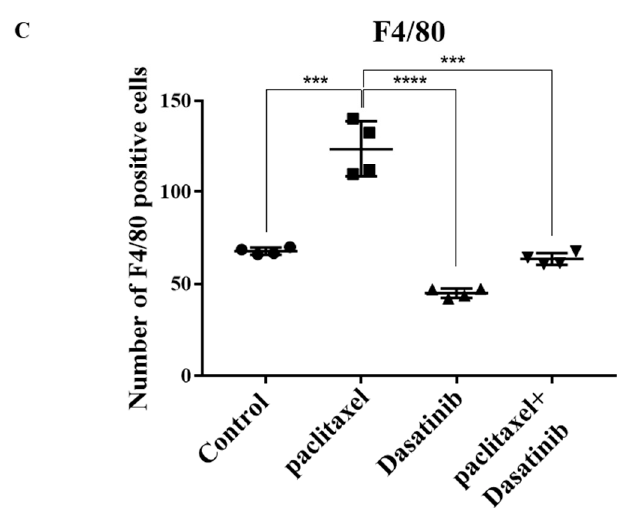
Figure 7. Dasatinib treatment reduces tumour invasion into organs and reduces infiltration of macrophages in tumours. ( A ) Histological analysis of liver, pancreas and intestines showing tumour attachment/invasion, post 12 days of treatment. Magnification 200 × scale bar = 200 µ M. ( B ) Immunohistochemical staining of F4/80 macrophage marker in liver lesions and omental tumours. Magnification 200 × scale bar = 200 µ M. ( C ) Quantification of F4/80 DAB staining in omental tumours using Fiji software. Results are displayed as number of positive cells ± SD. Significance between the groups and is indicated by *** p < 0.001, **** p < 0.0001.